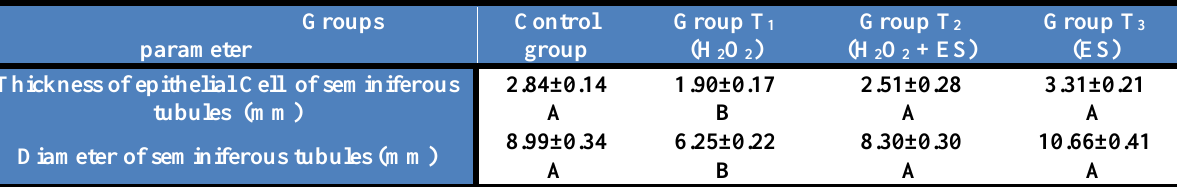
Table, 1: Effect of Eruca sativa extract and hydrogen peroxide on histological architecture of seminiferous tubules in adult male rats.